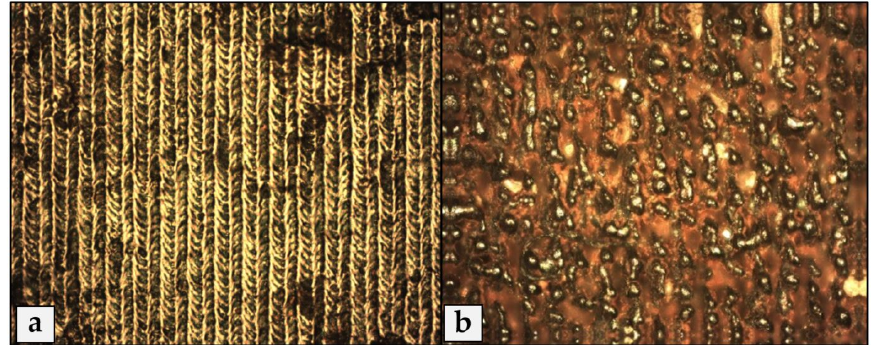
Figure 14. Surface differences obtained by laser texturing at 20×: ( a ) 5 W and 250 mm/s; ( b ) 20 W and 10 mm/s. Metals 2019 , 9 , x FOR PEER REVIEW